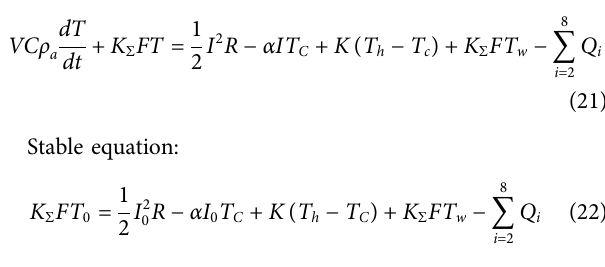
Frontiers in Energy Research |